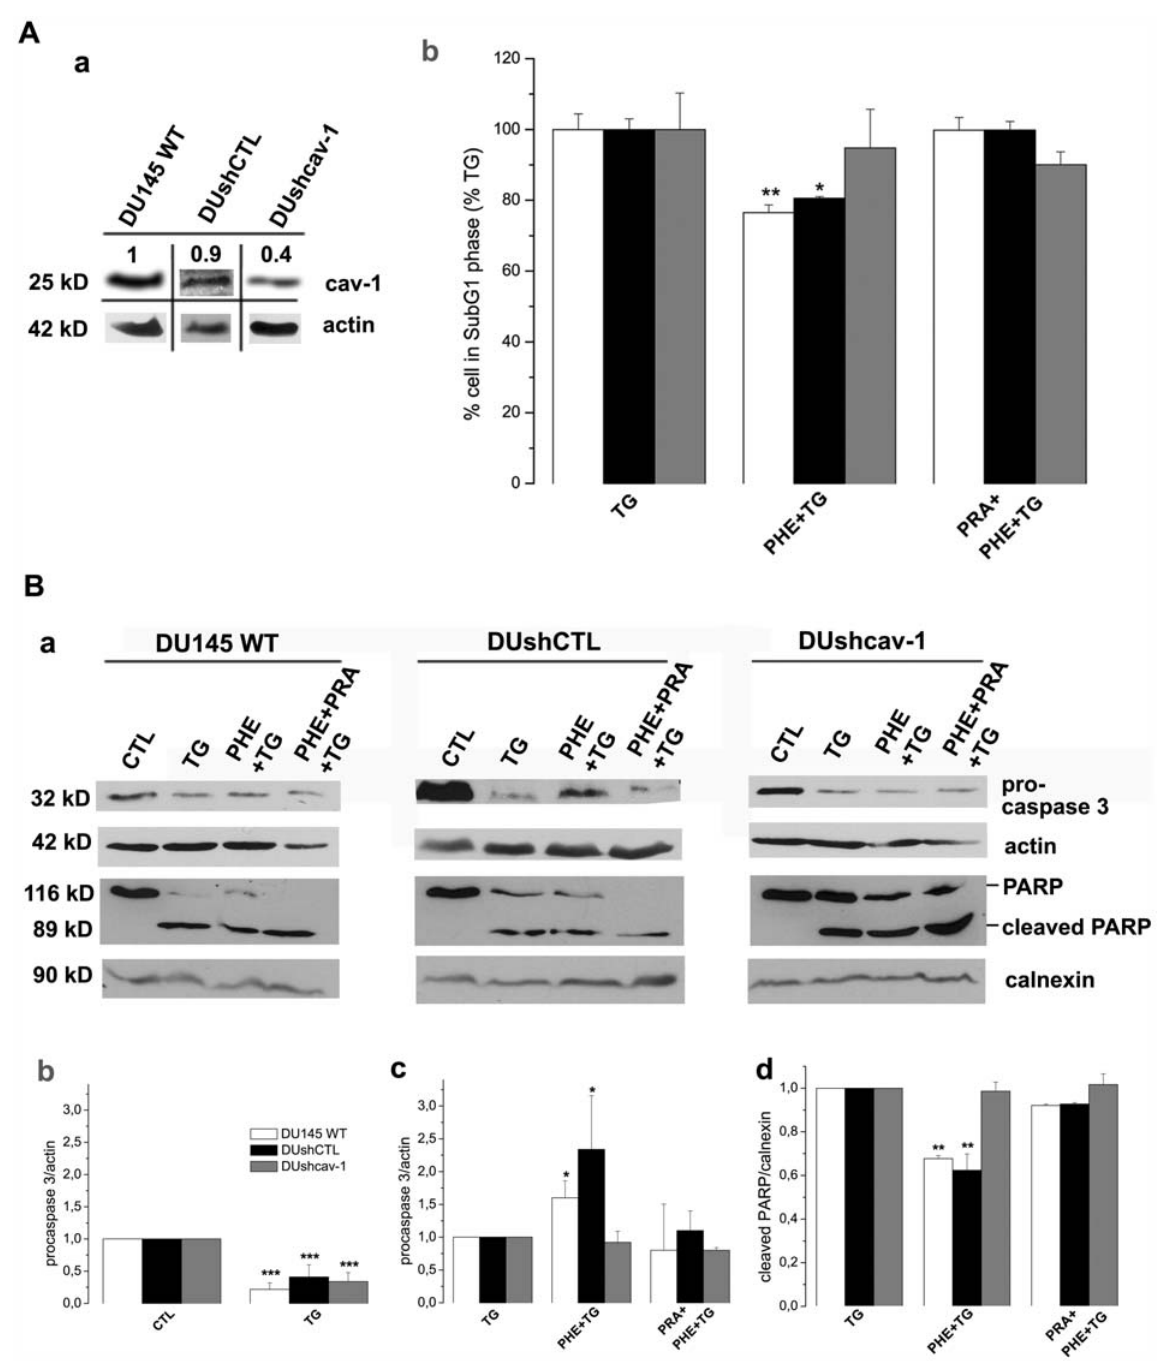
Figure 4. Apoptosis resistance of DU145 cells depends on caveolin-1 expression and is mediated by the caspase-3 pathway. (A)(a) Western blot showing the expression of caveolin-1 (cav-1) in DU145 cells stably transfected with Psuper plasmid expressing shRNA against cav-1 (DUshcav-1) and with empty Psuper plasmid (DUshCTL). Images are grouped from different lanes of the same gel and numbers above gels indicate relative expression assessed on actin expression. (b) Cells were treated during 48 hrs with 10 m M Thapsigargin (TG) for induction of apoptosis, preceded by a 3-day renewable treatment with 10 m M phenylephrine alone (PHE + TG) or simultaneously with prazosin (PRA + PHE + TG), then analyzed by flow cytometry of propidium iodide-stained nuclei. Experiments were carried out in DU145 non-transfected cells (DU145 WT, white columns), DUshCTL cells (black columns) and DUshcav-1 cells (grey columns). Error bars represent SEM calculated from four independent experiments. Statistical analysis used t test; *, p , 0.05, **, P , 0.01. (B)(a) Expression levels of pro-caspase 3 and PARP (full-length and cleaved fragment) in DU145 WT, DUshCTL and DUshcav-1, after treatments indicated above were determined by western blot analysis and analyzed by scanning densitometry using actin immunoblotting (for procaspase-3) and calnexin (for cleaved PARP) as internal controls. (b, c, d) Average densitometries are represented by histograms for non-transfected (white columns), control shRNA (black columns) and caveolin-1 shRNA expressing cells (grey columns). Plots are the average cumulative data (mean 6 SEM) of three experiments. Statistical analysis used the t test; *, p , 0.05, **, p , 0.01 and ***, p , 0.001.